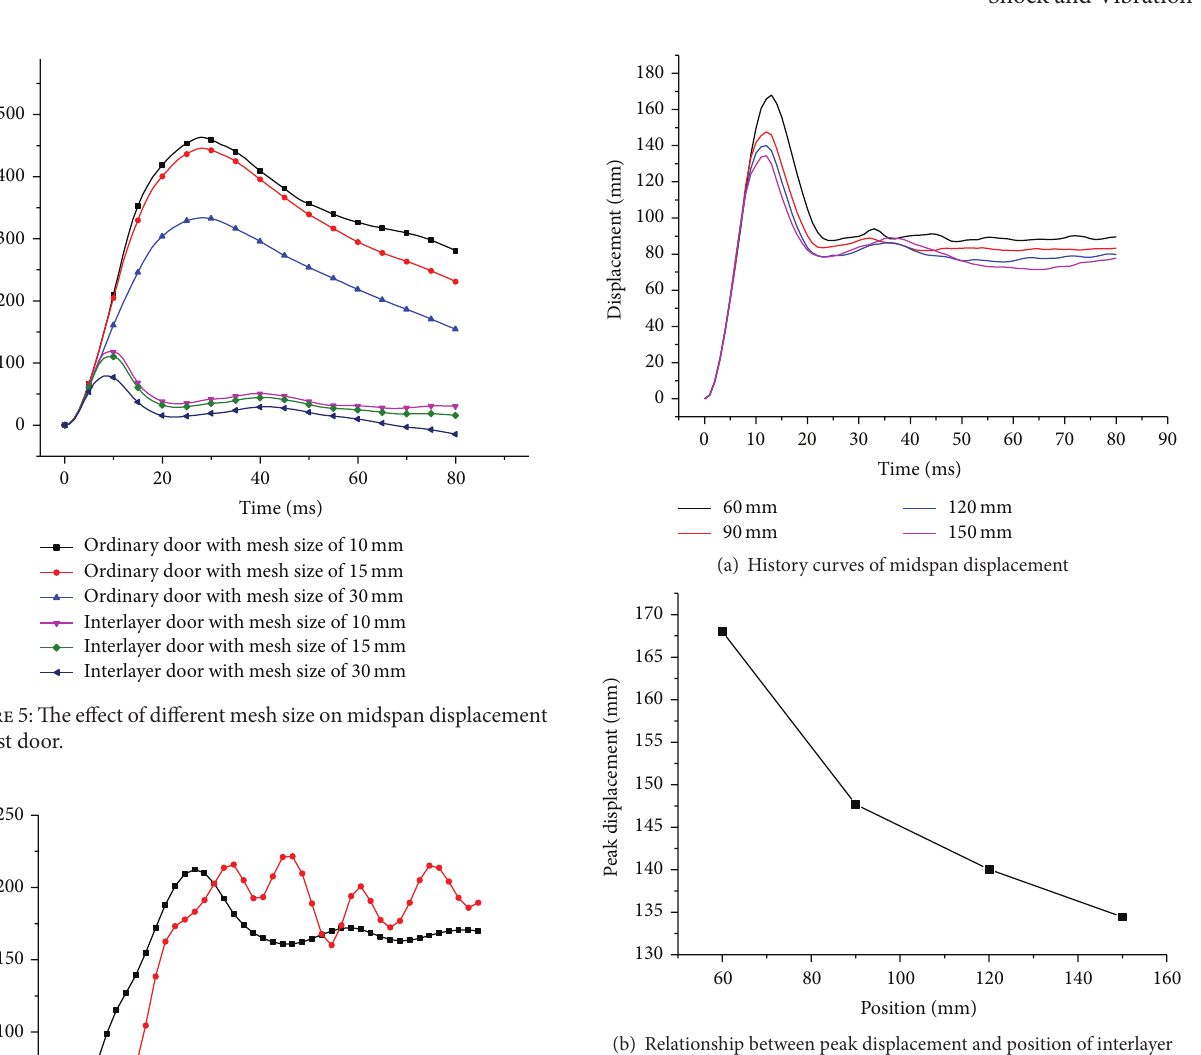
Figure 7: Effect of interlayer position on the displacement of blast